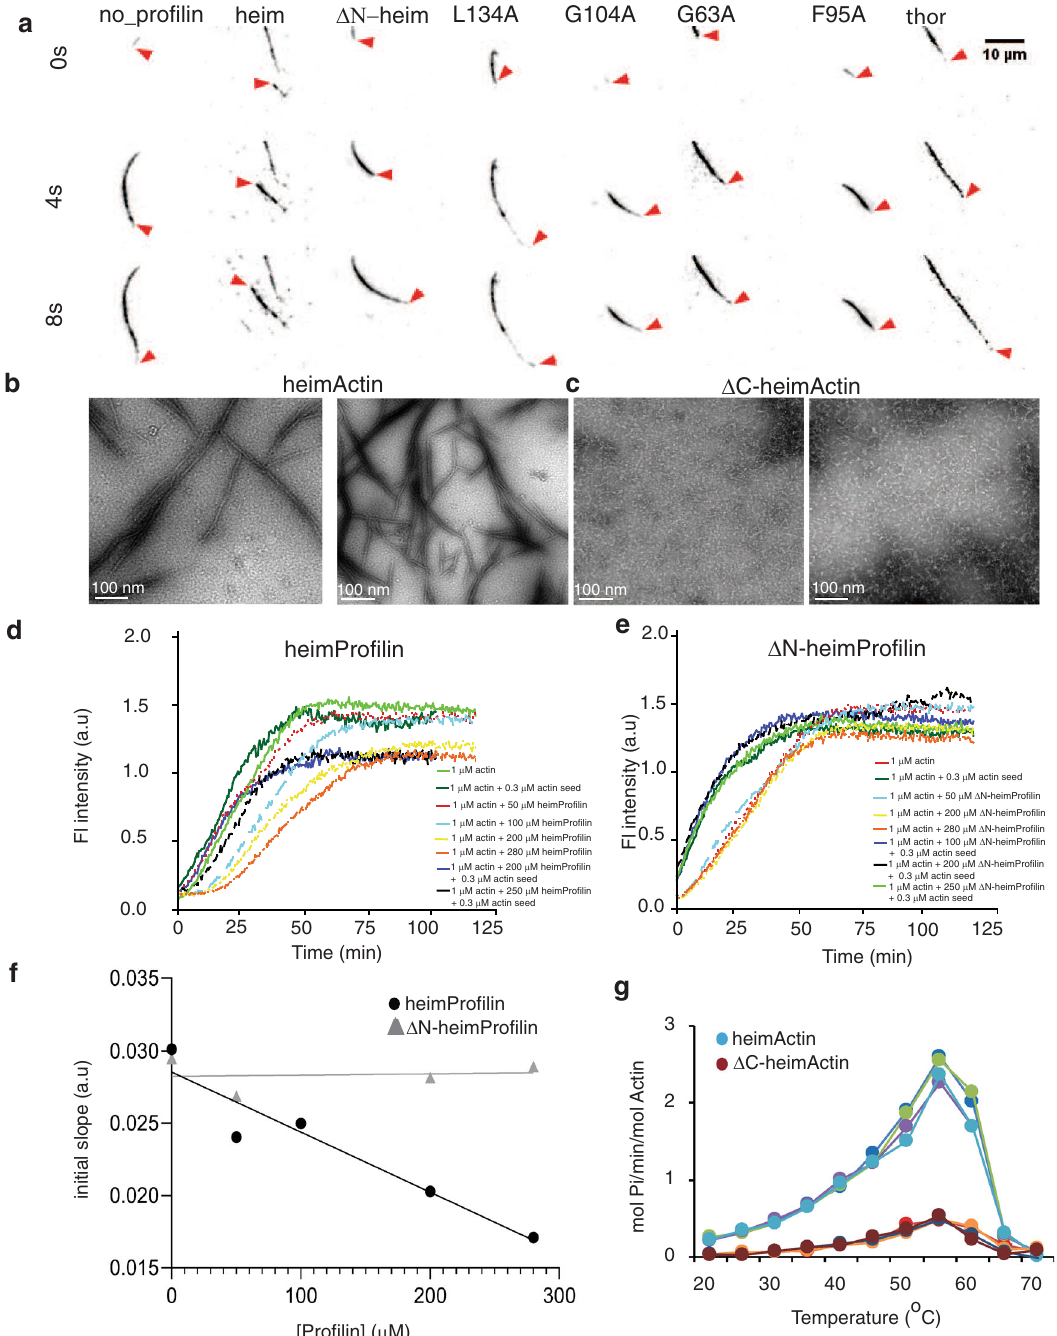
Fig. 2 Heimdallarchaeota encoded actin (heimActin) and rabbit actin polymerization are modulated by heimPro fi lin. Time dependent Total Internal Re fl ection Fluorescence (TIRF) Microscopy of ( a ) 1 μ M of rabbit actin labeled with 0.3% Alexa Fluor 568 and 0.2% Biotin-actin supplemented with 100 μ M of heimPro fi lin, pro fi lin mutants or thorPro fi lin. b – c Electron microscopy (EM) images (at 100 nm scale) of heimActin ( b ) forming thin, uniform fi lamentous polymers and Δ C-heimActin ( c ) forming irregular, amorphous structures. Scale bar: 100 nm. d Pyrene-polymerization pro fi les of 1 μ M rabbit actin (2% pyrene-labeled) alone or supplemented with 0.3 μ M actin seeds with different concentrations of heimPro fi lin; 1 μ M actin alone (light green), 1 μ M actin with 0.3 μ M actin seed (dark green), 50 μ M (red), 100 μ M (cyan), 200 μ M (yellow), 280 μ M (orange), 200 μ M (blue) with 0.3 μ M actin seed, and 250 μ M (black) with 0.3 μ M actin seed. e Pyrene-polymerization pro fi les of 1 μ M of rabbit actin (2% pyrene-labeled) alone or supplemented with 0.3 μ M actin seeds with different concentrations of Δ N-heimPro fi lin; 1 μ M actin alone (red), 1 μ M actin with 0.3 μ M actin seed (dark green), 50 μ M (cyan), 200 μ M (yellow), 280 μ M (orange), 100 μ M (blue) with 0.3 μ M actin seed, 200 μ M (black) with 0.3 μ M actin seed and 250 μ M (light green) with 0.3 μ M actin seed. f initial slopes of the pyrene polymerization assays in ( d ) and ( e ) plotted as a function of heimPro fi lin and Δ N-heimPro fi lin concentrations. The slopes were obtained from the linear phase of the reaction after removing the lag phase. g ATP hydrolysis during polymerization of heimActin (cyan, green, purple and blue) or Δ C-heimActin (brown, red, orange, and dark-red) as a function of temperature. Four replicates from each experiment is plotted as function of